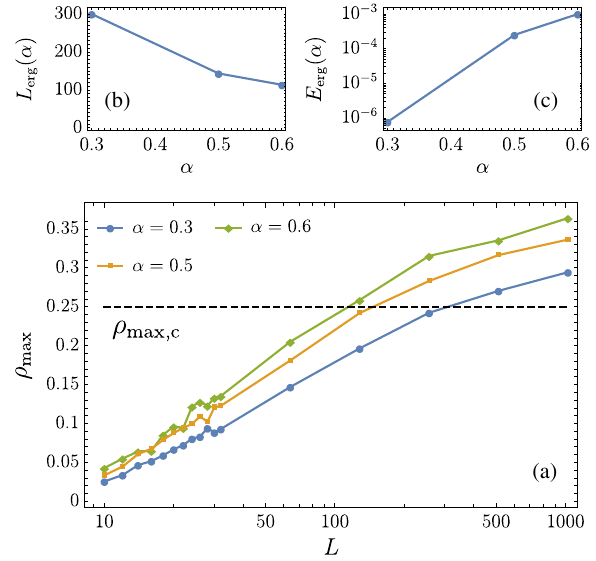
FIG. 17. (a) Maximum density ρ of the resonant spins max developed in the course of the SDRG (cf. Fig. 16) as a function ∼ ρ of the system size. The condition ρ defines the max max ;c α Þ and the corresponding energy ergodization length scale L erg ð α Þ ¼ V α Þ(cid:3) . (b), (c) Estimates for the ergodiza- L scale E erg ð typ ½ erg ð tion length and energy scales obtained by fixing the critical 0 . 25 density to ρ max ;c ¼